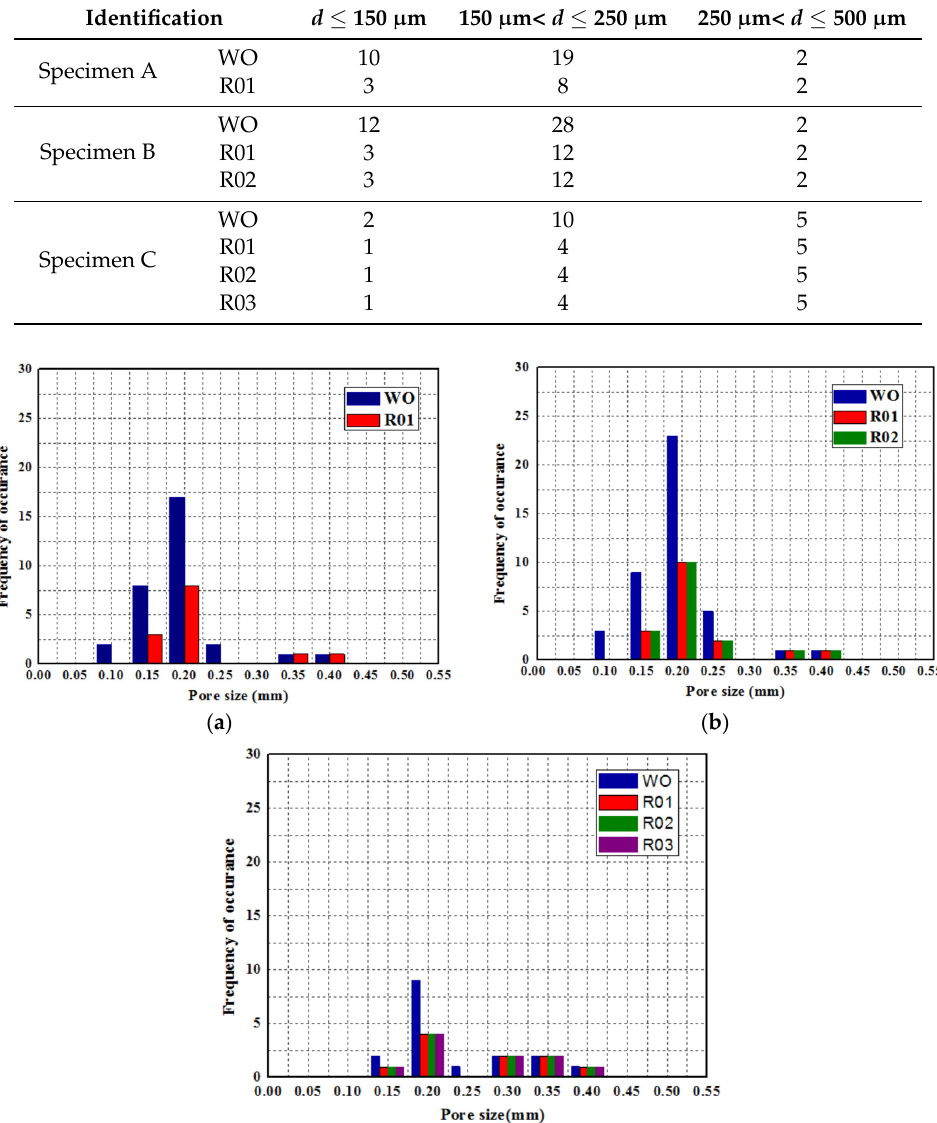
Table 4. Results of X-ray inspection, quantity, and size of pores ( d ).